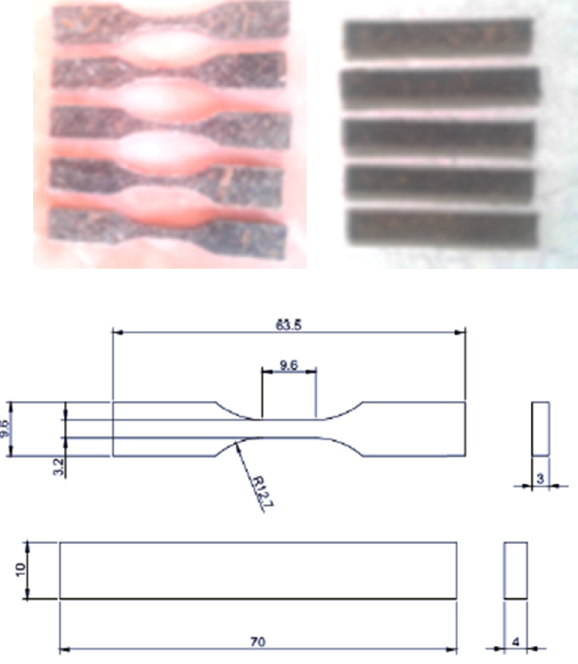
Figure 1: Tensile andimpact specimens ofr -